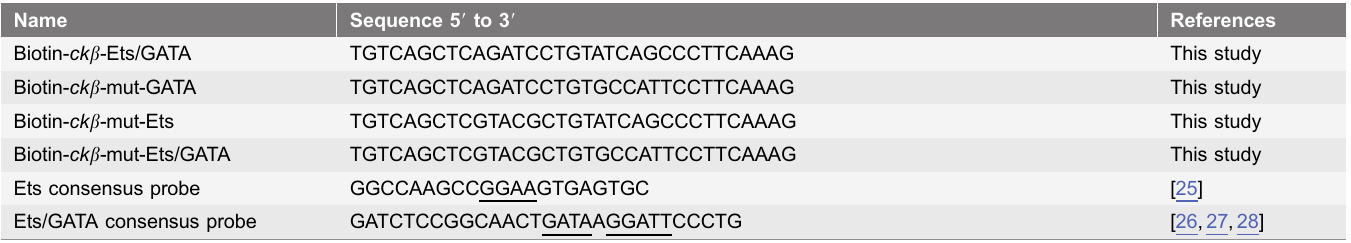
Table 2. DNA probes used in EMSA. The Ets and GATA core sequences are